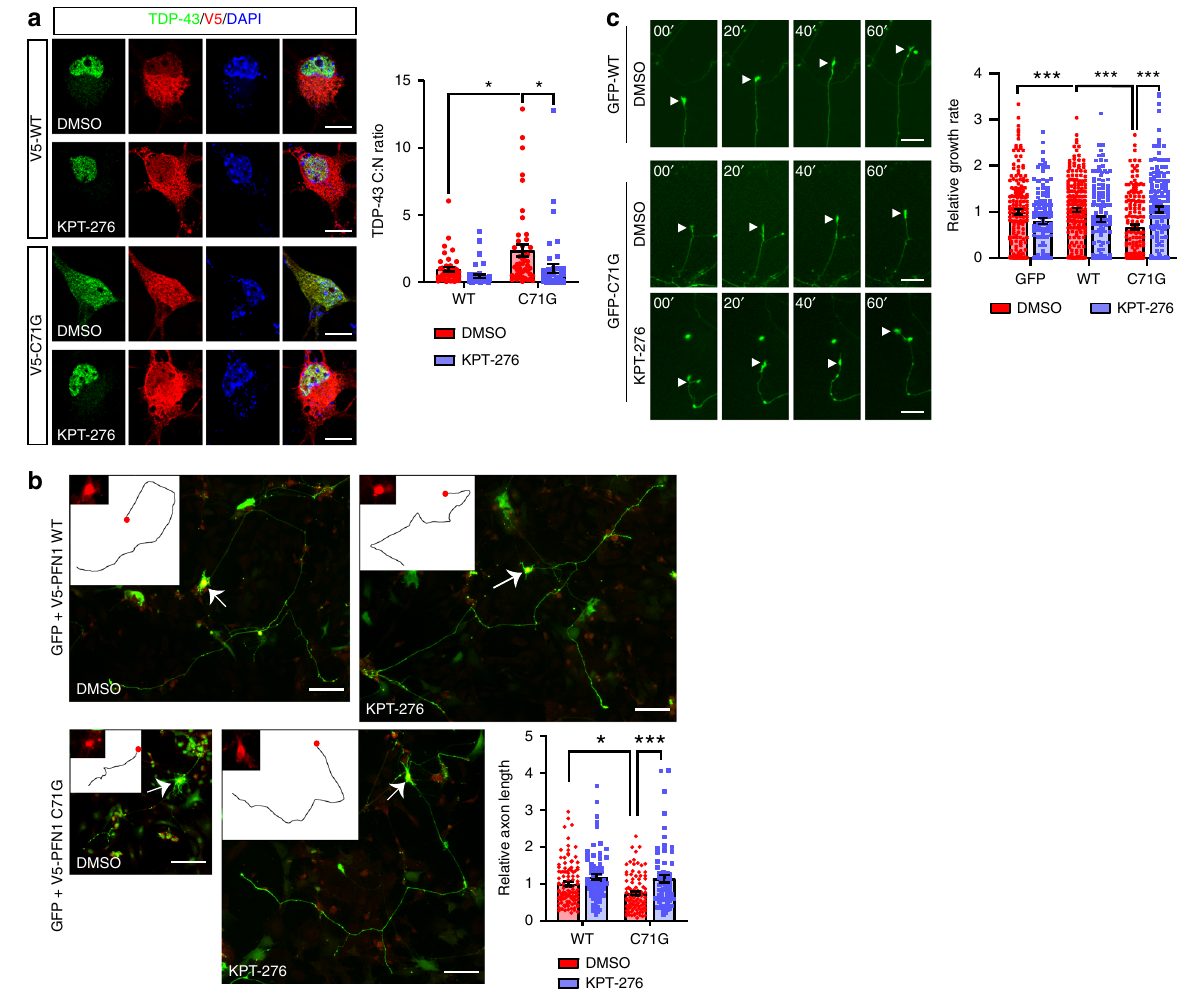
Fig. 6 Inhibition of nuclear export rescues PFN1-dependent cellular defects. a KPT-276 treatment rescues TDP-43 (green) C:N ratio in MNs expressing mutant PFN1 (red). b MNs expressing PFN1 C71G had signi fi cantly shorter axons compared to WT-expressing cells. This defect was fully rescued by KPT- 276 treatment. Insets show the tracing of the primary axon and the expression of V5-PFN1 in the cell body (red, arrows). c Representative time lapse images and quanti fi cation of axon outgrowth in the presence or absence of KPT-276. A full rescue of the outgrowth defects was observed following KPT- 276 treatment. DAPI (blue) was used to detect the nucleus and assess cell health. DMSO was used as vehicle control. Scale bars: 10 µ m. Bars are mean ± SEM; * p < 0.05, *** p < 0.001. N = 40 – 46 cells from 4 independent experiments ( a ), 67 – 107 cells from 4 independent experiments ( b ), 116 – 207 cells